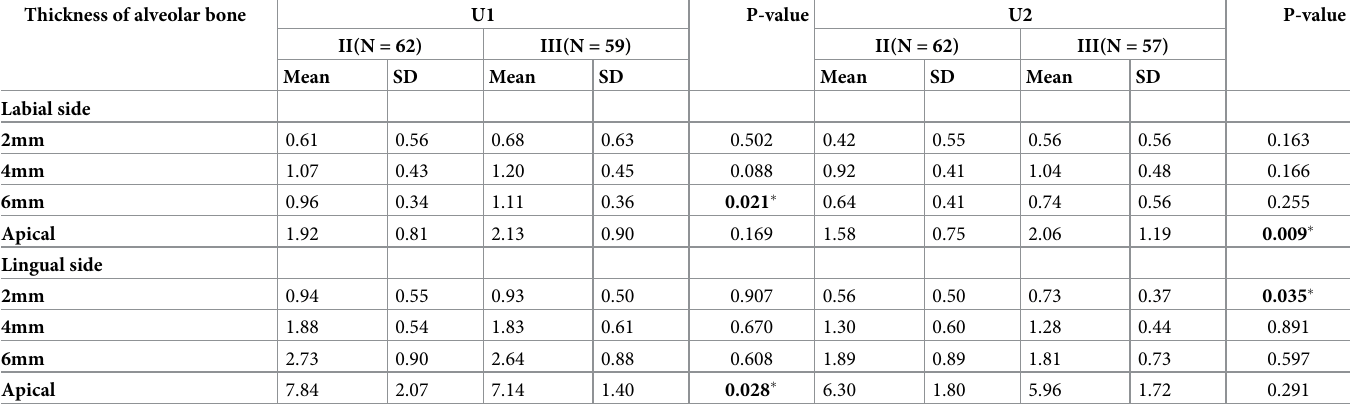
Table 7. Comparison of the thickness of maxillary alveolar bone between skeletal Class II malocclusion patients and skeletal Class III malocclusion patients (mm). Thickness of alveolar bone U1